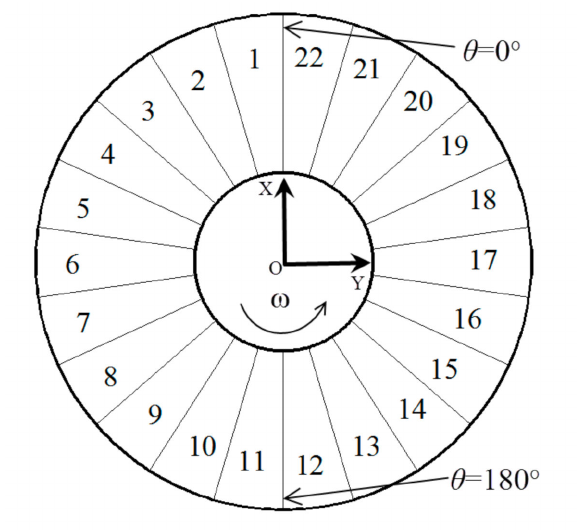
Figure 13. Circumferential distribution of